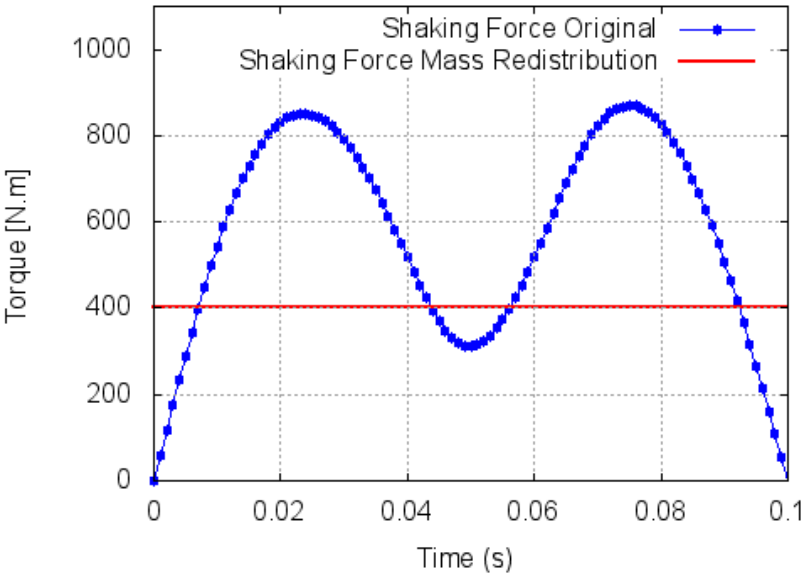
Figure 10. Comparison of the shaking force. The blue curve is the magnitude of the shaking force in the original manipulator. The red line is the magnitude of the shaking force when the mass of the driving links are redistributed and the tool is guided with a “bang-bang”